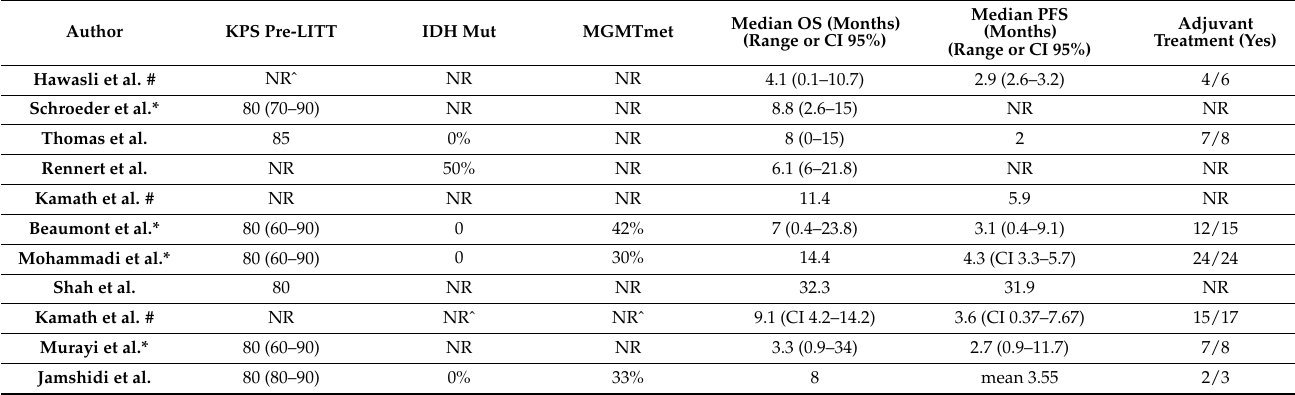
Table 4. Overall survival (OS) and progression free survival (PFS) are reported with respective range of CI 95% when reported in the original studies.